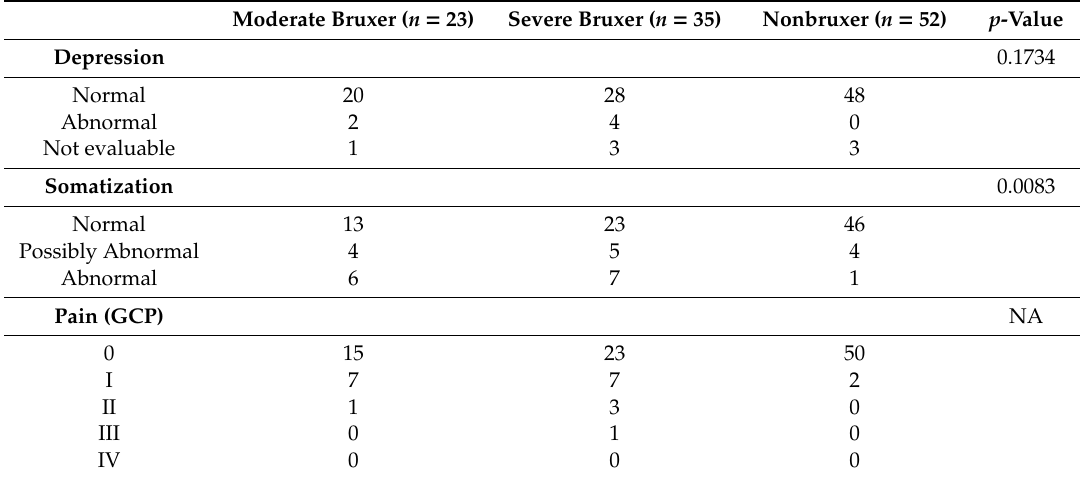
Table 2. Correlation between moderate ( > 2 and ≤ 4 SB episodes / h) and severe ( > 4 SB episodes / h) sleep bruxism and depression, somatization, and pain (GCP). Moderate Bruxer ( n = 23) Severe Bruxer ( n = 35) Nonbruxer ( n = 52) p -Value Depression 0.1734 Normal 20 28 48 Abnormal 2 Not evaluable Somatization 0.0083 Normal Abnormal